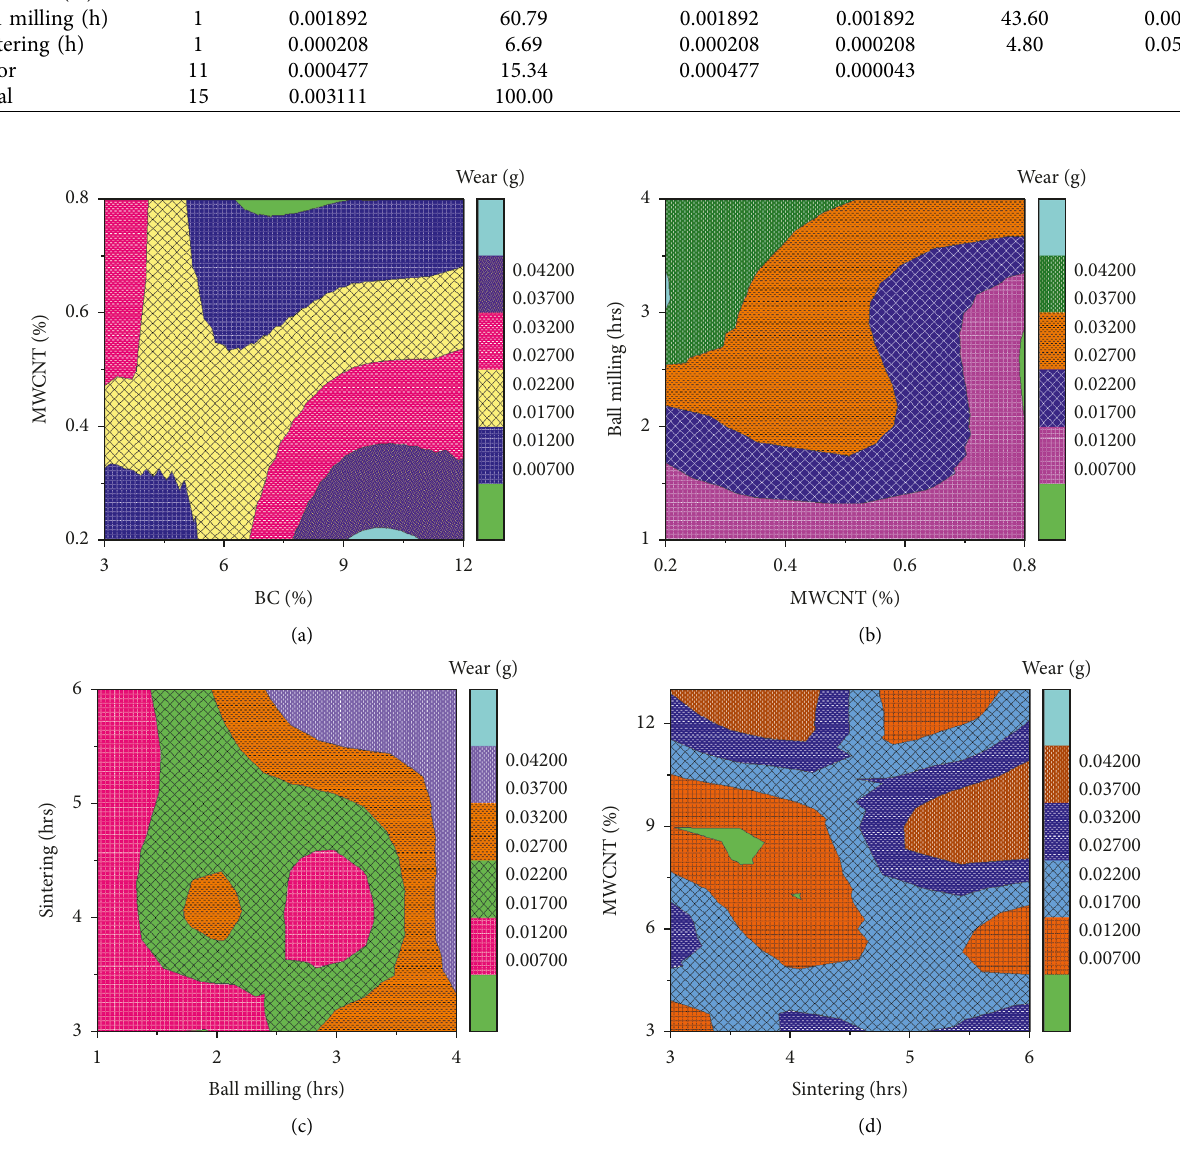
Figure 8: Contour plot for wear analysis: (a) B 4 C % vs. MWCNT; (b) MWCNTvs. ball milling; (c) ball milling vs. sintering; (d) sintering vs. MWCNT.